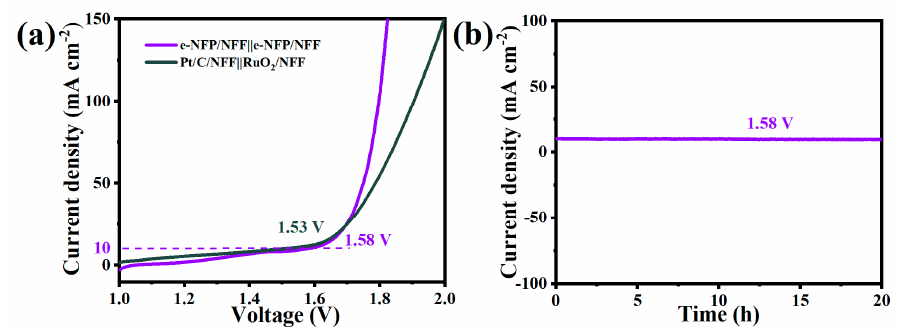
Figure 8. ( a ) Polarization curves of OWS for e − NFP/NFF and Pt/C||RuO 2 ; ( b ) Chronoamperometry curve of e − NFP/NFF for OWS at a voltage of 1.58 V.